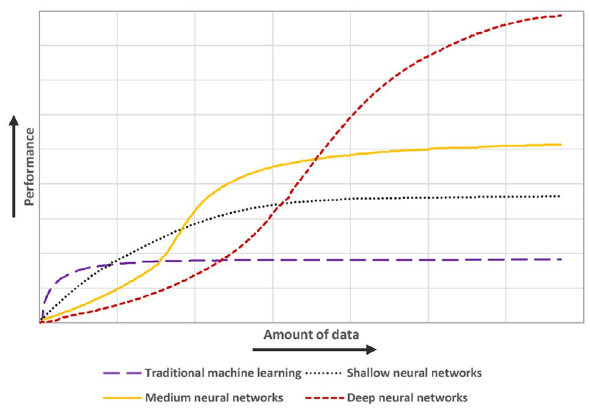
Fig. 4 A schematic diagram showing the relative performance curves versus available data for different ML algorithms (Osarogiag- bon et al. [56])